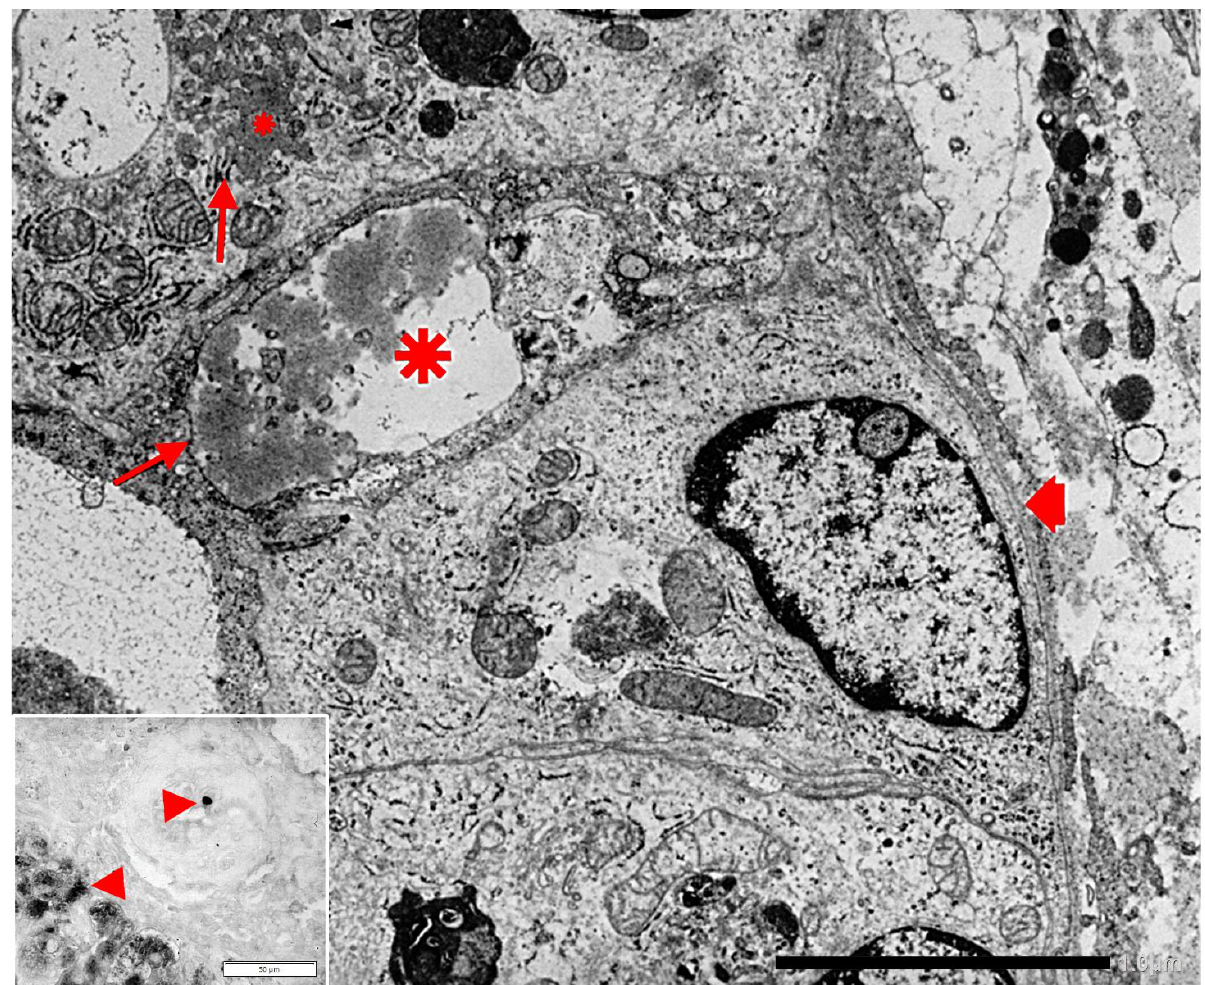
Figure 3. Pi ZZ patient’s liver. An interlobular bile duct shows an intercalated lining cell with an enlarged cisterna of the RER (big *) containing AAT-like material (EM × 11,500). The big arrow indicates a cytoplasmic area with communicating SER channels containing AAT-like material (small *). The inset shows the immunohistochemical staining of a tissue section from the same liver. A single large AAT inclusion is present at the apical pole of a bile duct cell (arrowhead). Periportal hepatocytes contain, as usual, AAT immunoreactive globules (arrowheads) (immunostaining × 600).